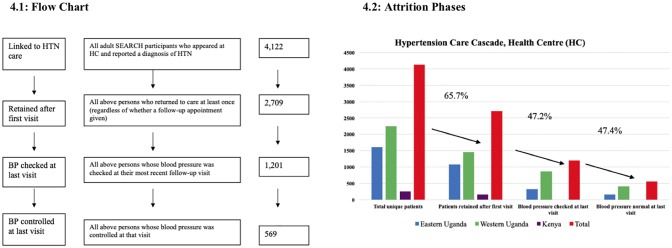
Consort diagram, fidelity, and outcome measures for health clinic hypertension cascade.Flow chart depicts stepwise care cascade; bar graphs depict size of cumulative attrition.